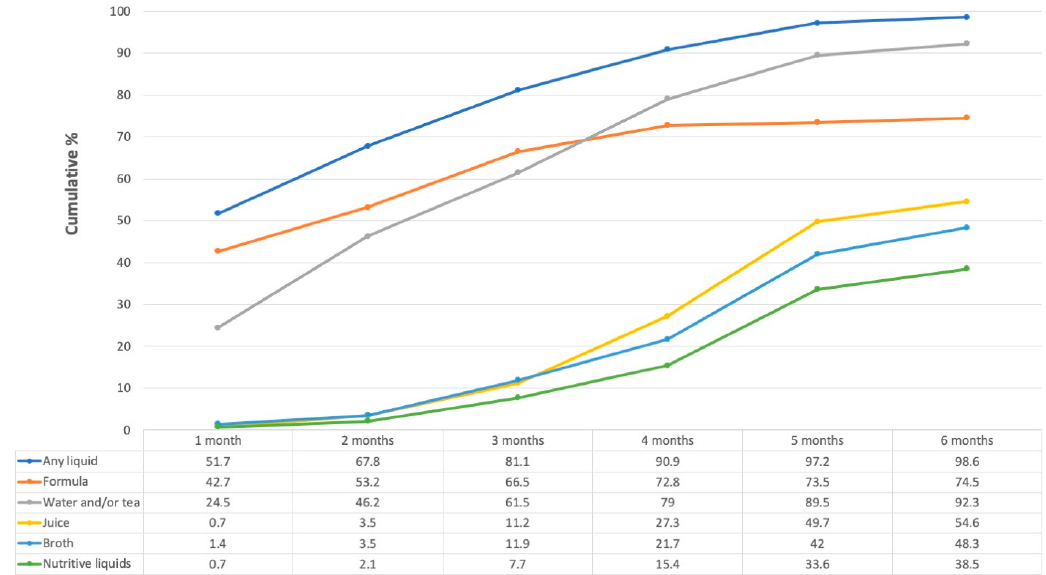
Figure 1. Liquid foods consumed over the first six months of life. Numbers in the table represent percentages. The “Any liquid” category is not the sum of the other categories, since some women could have given more than one liquid during the same month. “Broths” could be made of beans, chicken, beef, fish, lentils, or vegetables. “Nutritive liquids” include atole (maize flour with water/milk), pozol (maize dough with water and with or without cocoa), and oatmeal with cocoa. Which Women Gave Formula Milk?